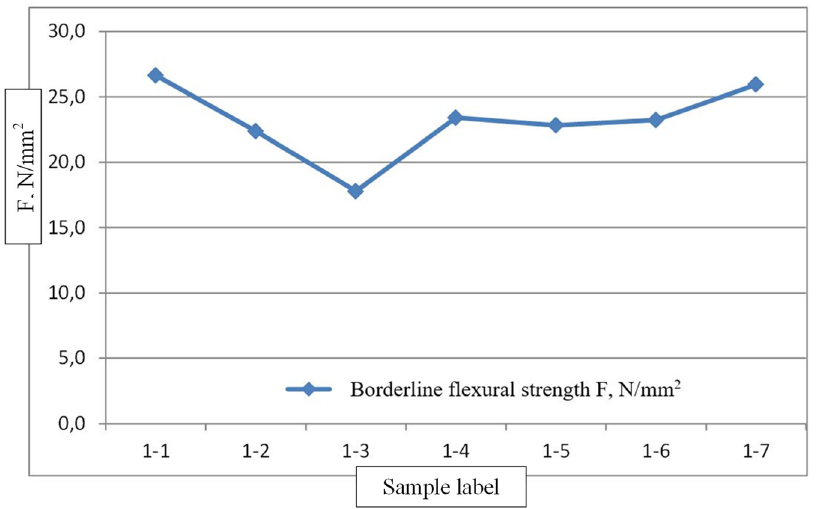
The average value of borderline flexural strength of samples of group No. 1 is 23.2 N/mm 2 (see Figure 3).